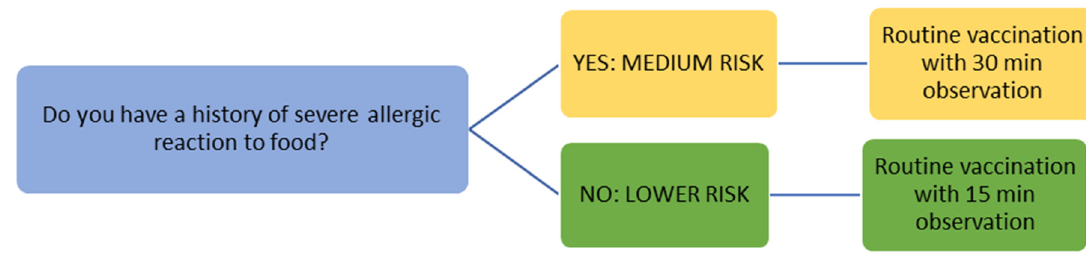
Figure 1. Vaccination in children with allergy to cow’s milk or other